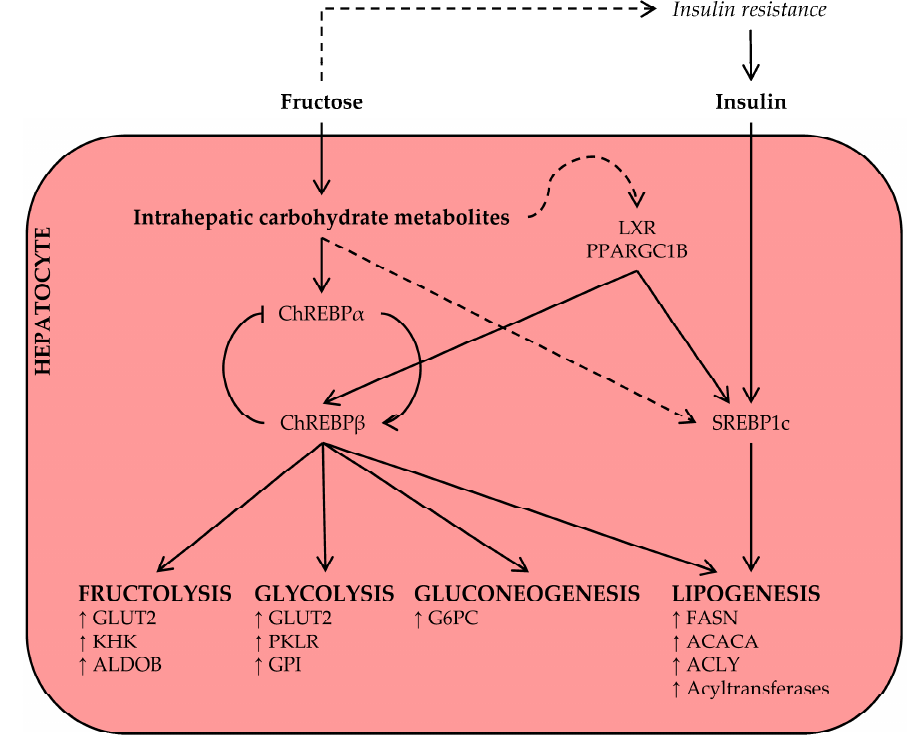
Figure 3. Chronic fructose consumption promotes mechanisms that upregulate the hepatic lipogenesis program. Hepatic metabolism of ingested fructose increases levels of intrahepatic carbohydrate metabolites. These act as nutritional regulators of key transcription factors, including carbohydrate response element-binding protein (ChREBP) and sterol regulatory element-binding protein 1c (SREBP1c), and coactivators for genes in multiple metabolic pathways. Stimulation of the lipogenesis program is further amplified by hyperinsulinemia in the context of insulin resistance. Other abbreviations: ACACA, acetyl-CoA carboxylase α ; ACLY, ATP citrate lyase; ALDOB, aldolase